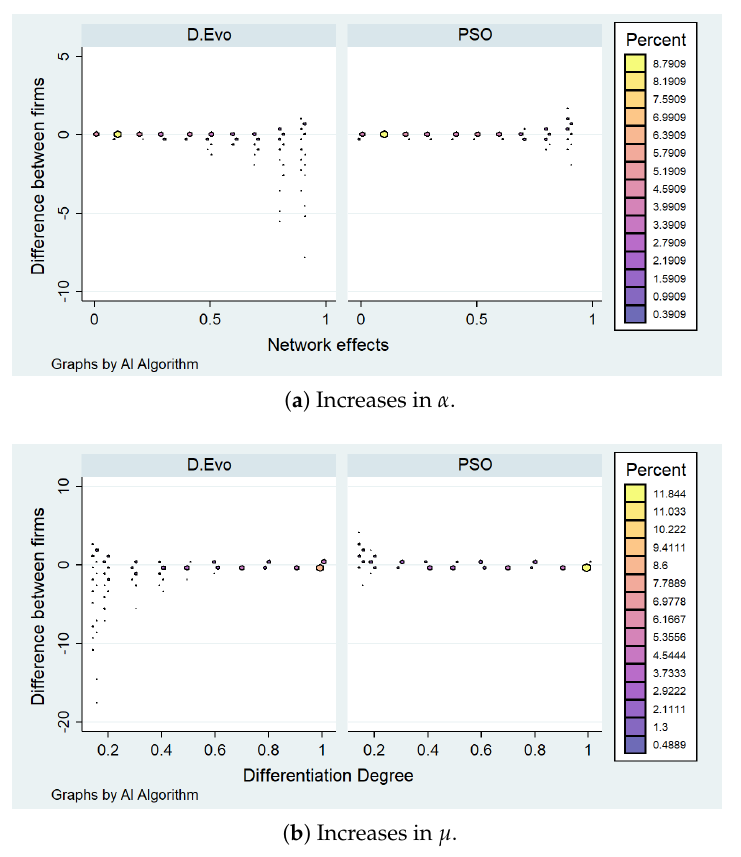
Figure 4. Difference between algorithms and a best-response platform. Left = network effects; Right = differentiation. Source: